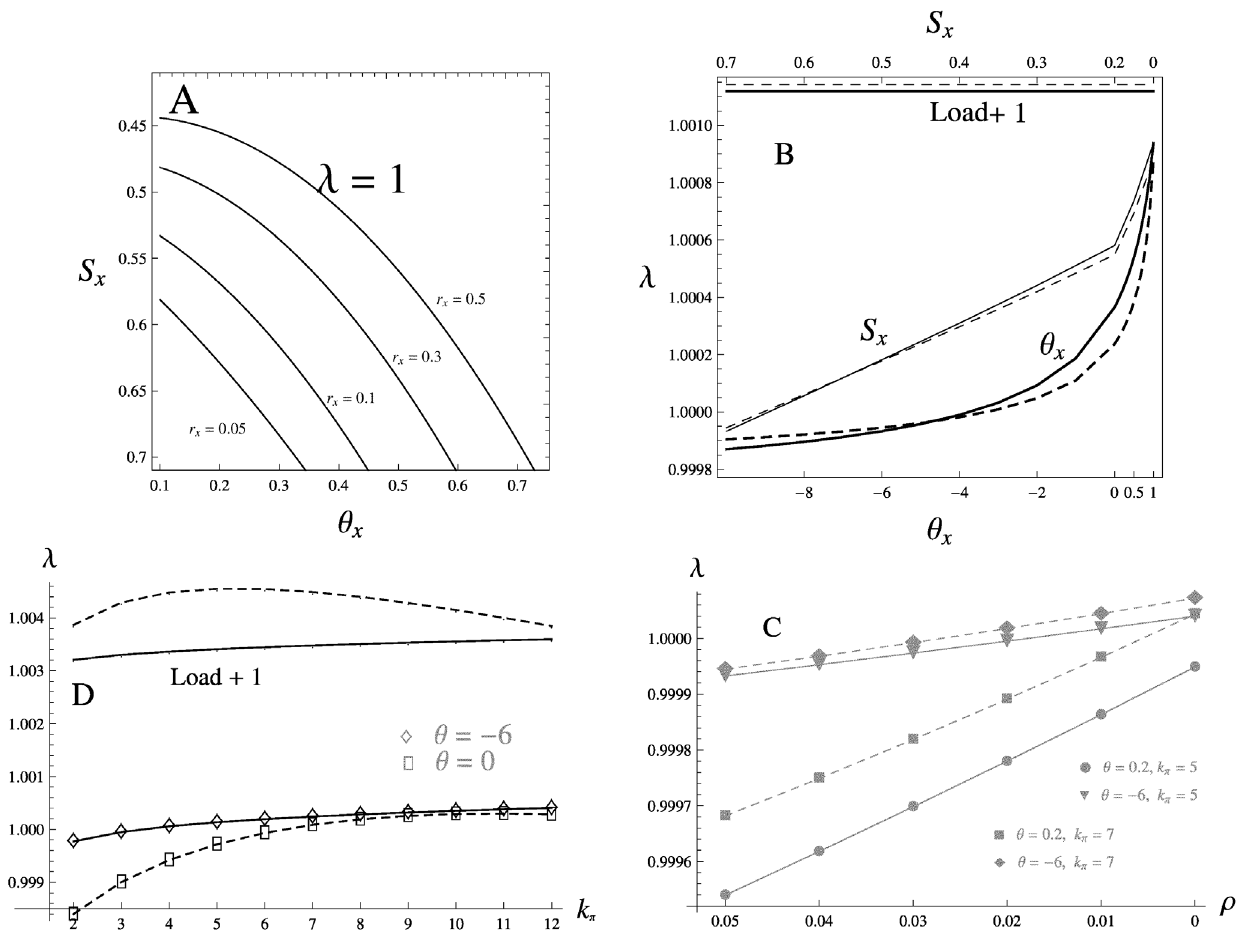
Figure 6. Selection acting on the invading modifier. A – view of the parameter space with the modifier selection strength S x ð Þ and epistasis h x ð Þ plotted on the X and Y axes, the leading eigenvalue of the invasion matrix ( l ) equals one along the lines shown for the following values of r x (top to bottom): 0.5, 0.3, 0.1, 0.05. The modifier is able to invade in the space above each line, and cannot invade below the line(s). Other parameters: S =0.7, h =0.2, m =0.003, r =0.001, k p =5. B – l as a function of the modifier epistasis, h x ð Þ , plotted on the bottom axis; and selection strength S x ð Þ , plotted on the top axis. The migration load (which is independent of S x , h x ) is shown by the horizontal line on the top. Solid lines indicate k p =5, dotted lines indicate k p =7. Other parameters: S =0.7, h =–6, m =0.001, r =0.05, r x = 0.1, n =10. C – Invasion rate of the modifier of recombination, as a function of the imposed recombination rate r . Markers indicate different values of the background epistasis, solid lines: k p =5, dotted lines: k p =7. Other parameters are as in B. D – Modifier of recombination invades non-monotonically with the length of the initial block, k p . Solid lines: k p =5, dotted lines: k p =7; markers indicate different values of the background epistasis. Migration load is shown at the top of the plot. Other parameters: S =0.7, m =0.003, r =0.05, r x = 0.1, n